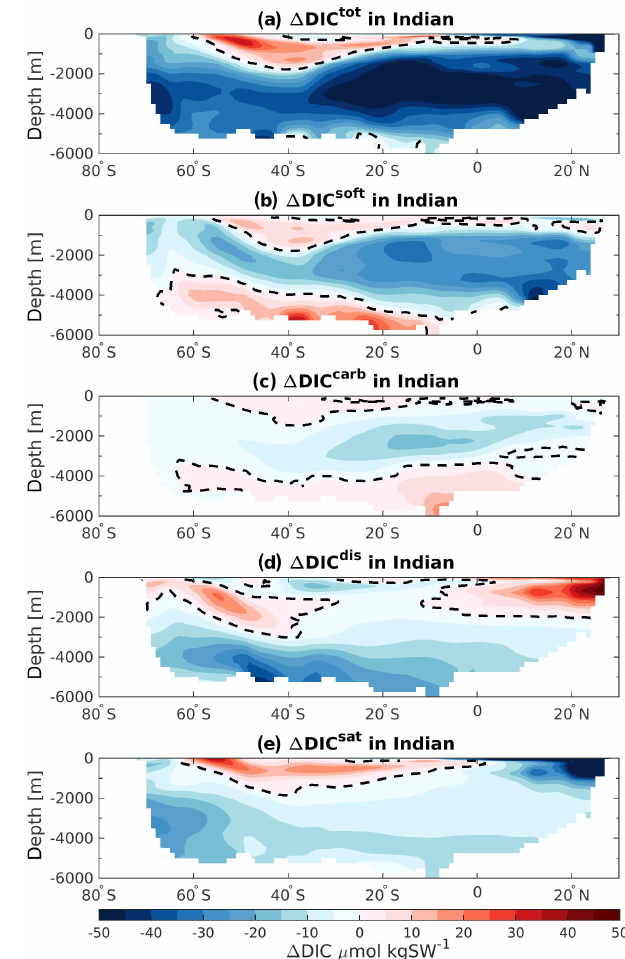
Figure 8. Same as Fig. 7 but for the Indian